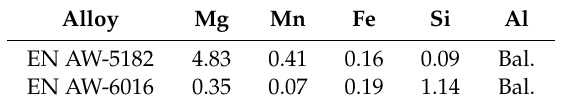
Table 1. Chemical composition of the studied alloys EN AW-5182 and EN AW-6016 (in wt %). Alloy Mg